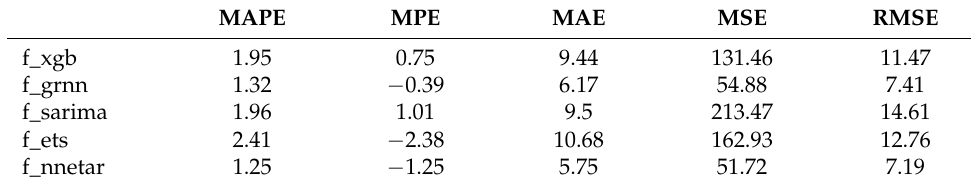
Table A3. Weekly forecast error measure.